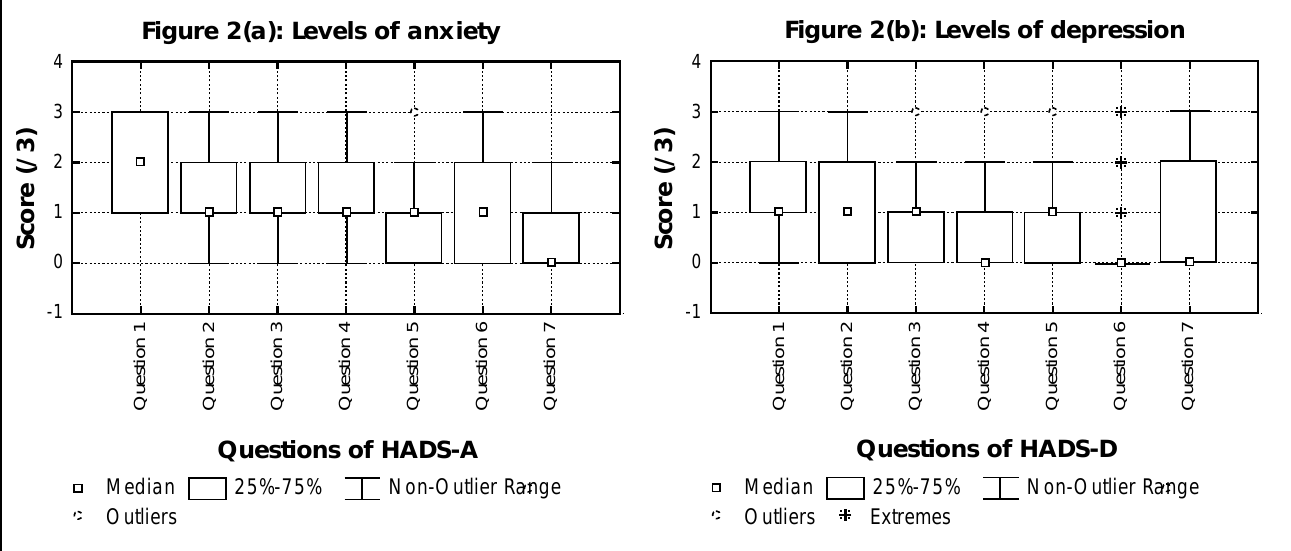
Figure 2: The scores obtained from the individual questions of the (a) HADS-A and (b) HADS-D (2D Box